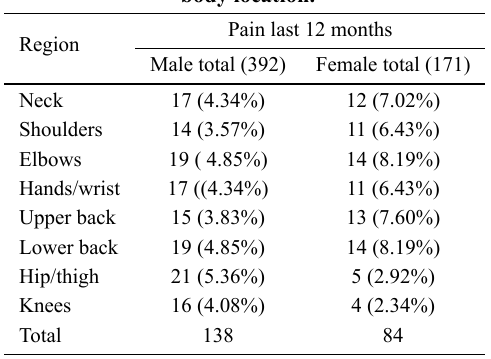
Table 5. Prevalence of musculoskeletal symptoms in each body